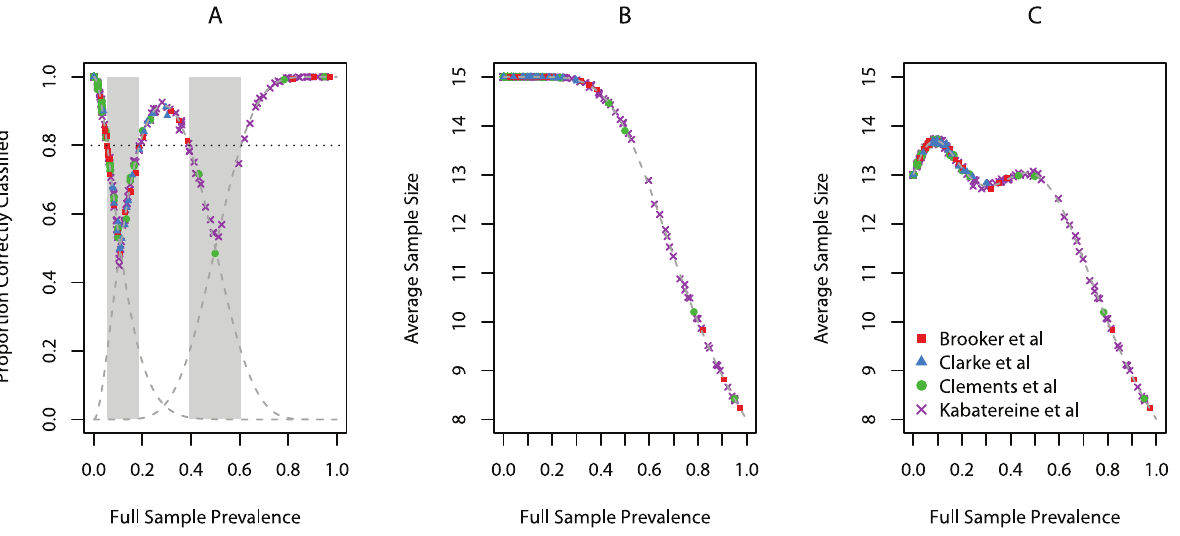
Figure 3. School-based simulation results. For simulation with n=15, d 1 =1, and d 2 =7, (A) average proportion of correctly classified schools with expected Operating Characteristic curves overlaid (dashed grey), (B) Average Sample Number when utilizing semi-curtailed sampling with expected Average Sample Number overlaid (dashed grey), and (C) Average Sample Number when utilizing curtailed sampling with expected Average Sample Number overlaid (dashed grey).